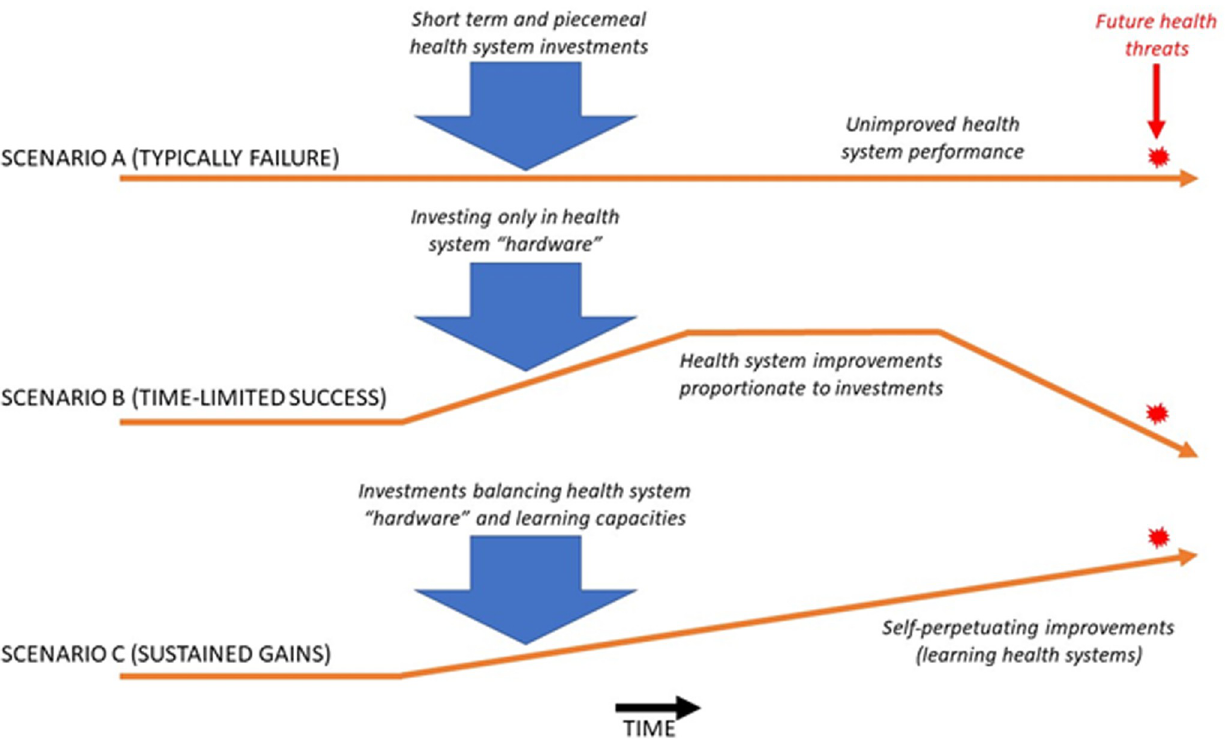
Fig 1. Outcomes of different types of investments in health